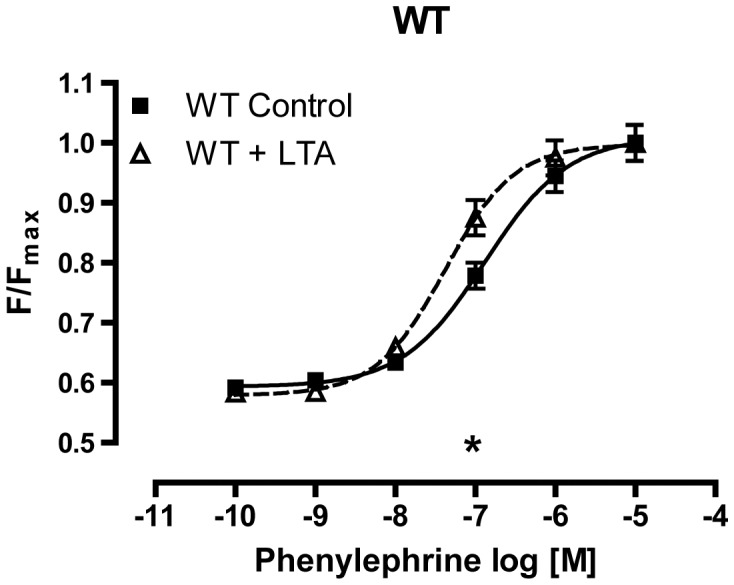
Influence of TLR2 agonism on aortic contractility.LTA application to WT mice increased contraction force at 10−7 M phenylephrine. Results were standardized to the maximum contraction force, which was not different between both groups (*p<0.05; n≥5 animals in each group; mean ± SEM).